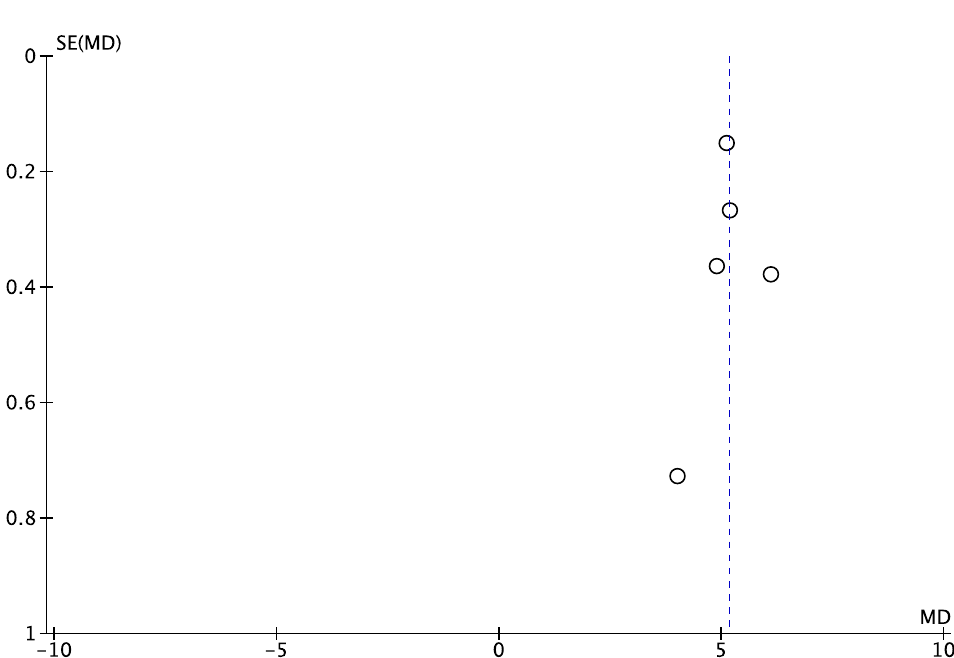
Figure 6. Forest plot of comparison: VAS, outcome in BT. SD: Standard Deviation.